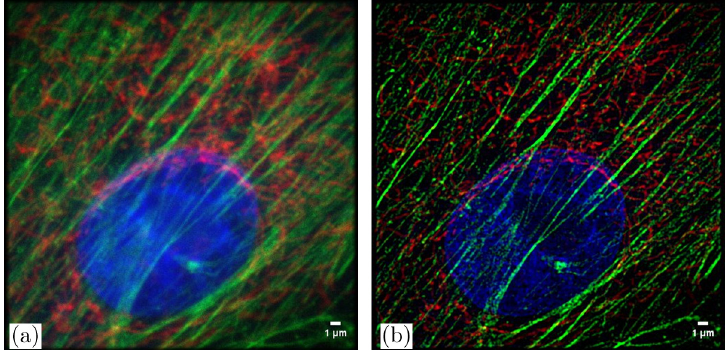
Fig. 8. Multi-color super-imposed WF (a) and SIM (b) images of trichrome-stained BPAE cells. Mitochondria are indicated in red, F-actins in green and nuclei in